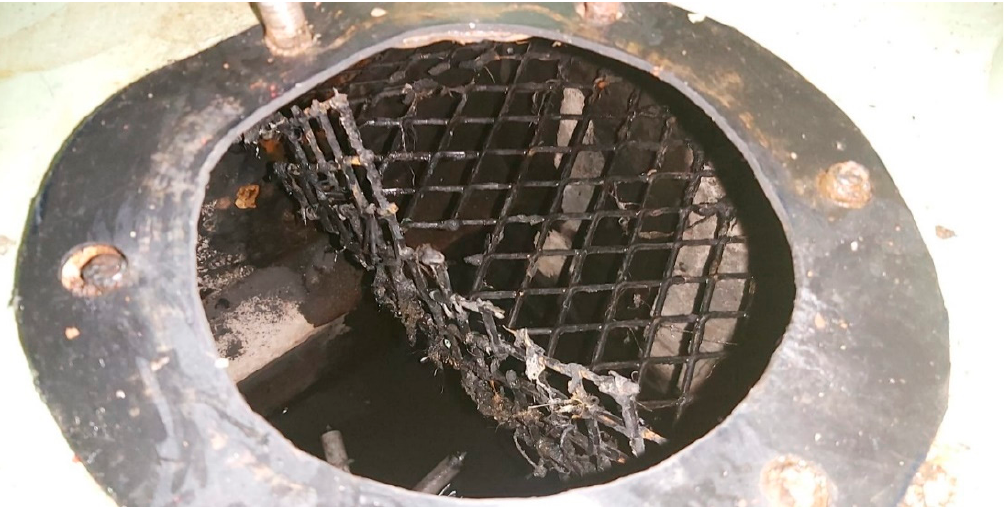
Figure 9. The coarse screen of mechanical purification plant.